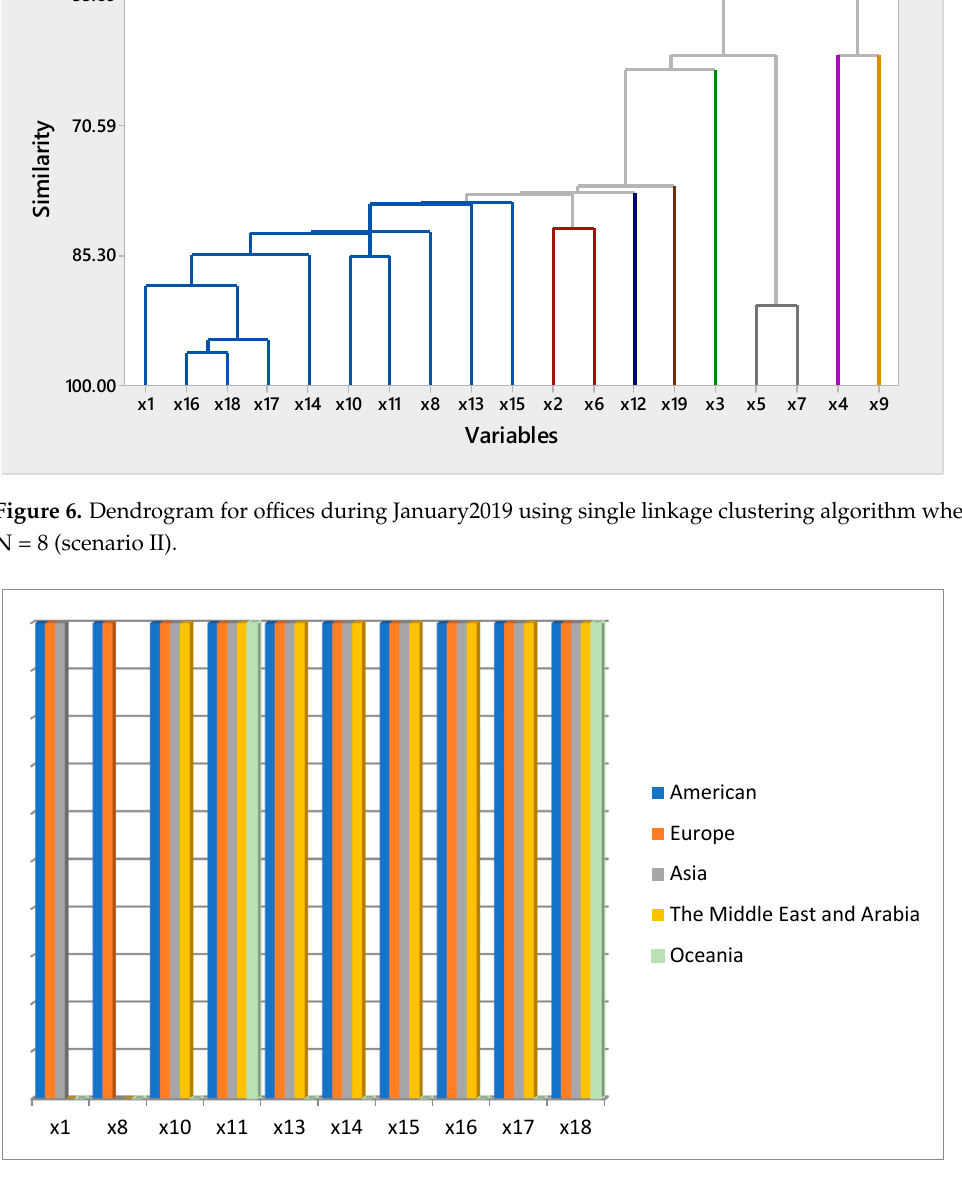
Figure 7. Cluster A content visualization using color coding for January when N = 8 . A cluster content explanation chart was used for all clusters throughout the year to monitor how the nationalities number changed in the same cluster from January to De- cember. For example: Figure 8 shows the cluster B content explanation chart. The y-axis represents the number of tourists for each geographical area in the cluster, and the x-axis represents the offices within cluster B throughout the year.